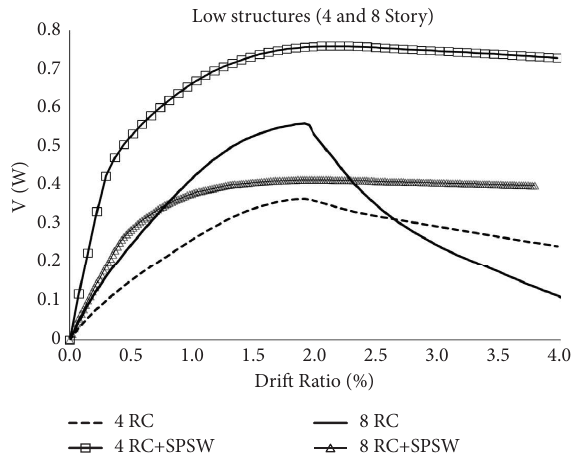
Figure 5: Result of nonlinear static analysis of low-rise